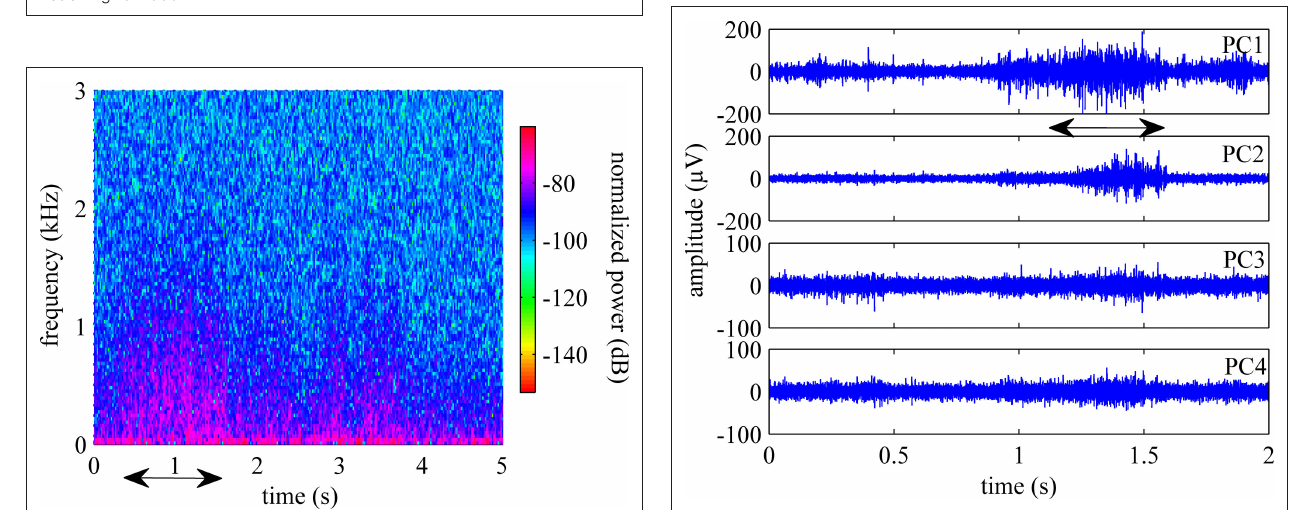
Figure 5 | First four principal components (PCs) of the population activity shown in Figure 4. The remaining three components, did not exhibit activity coincident with the